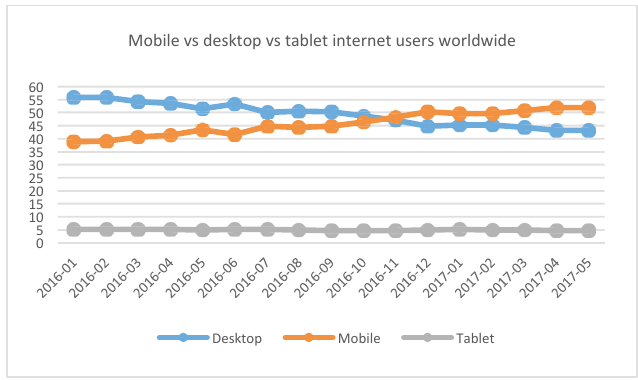
Mobile vs desktop vs tablet internet users worldwide Fig.